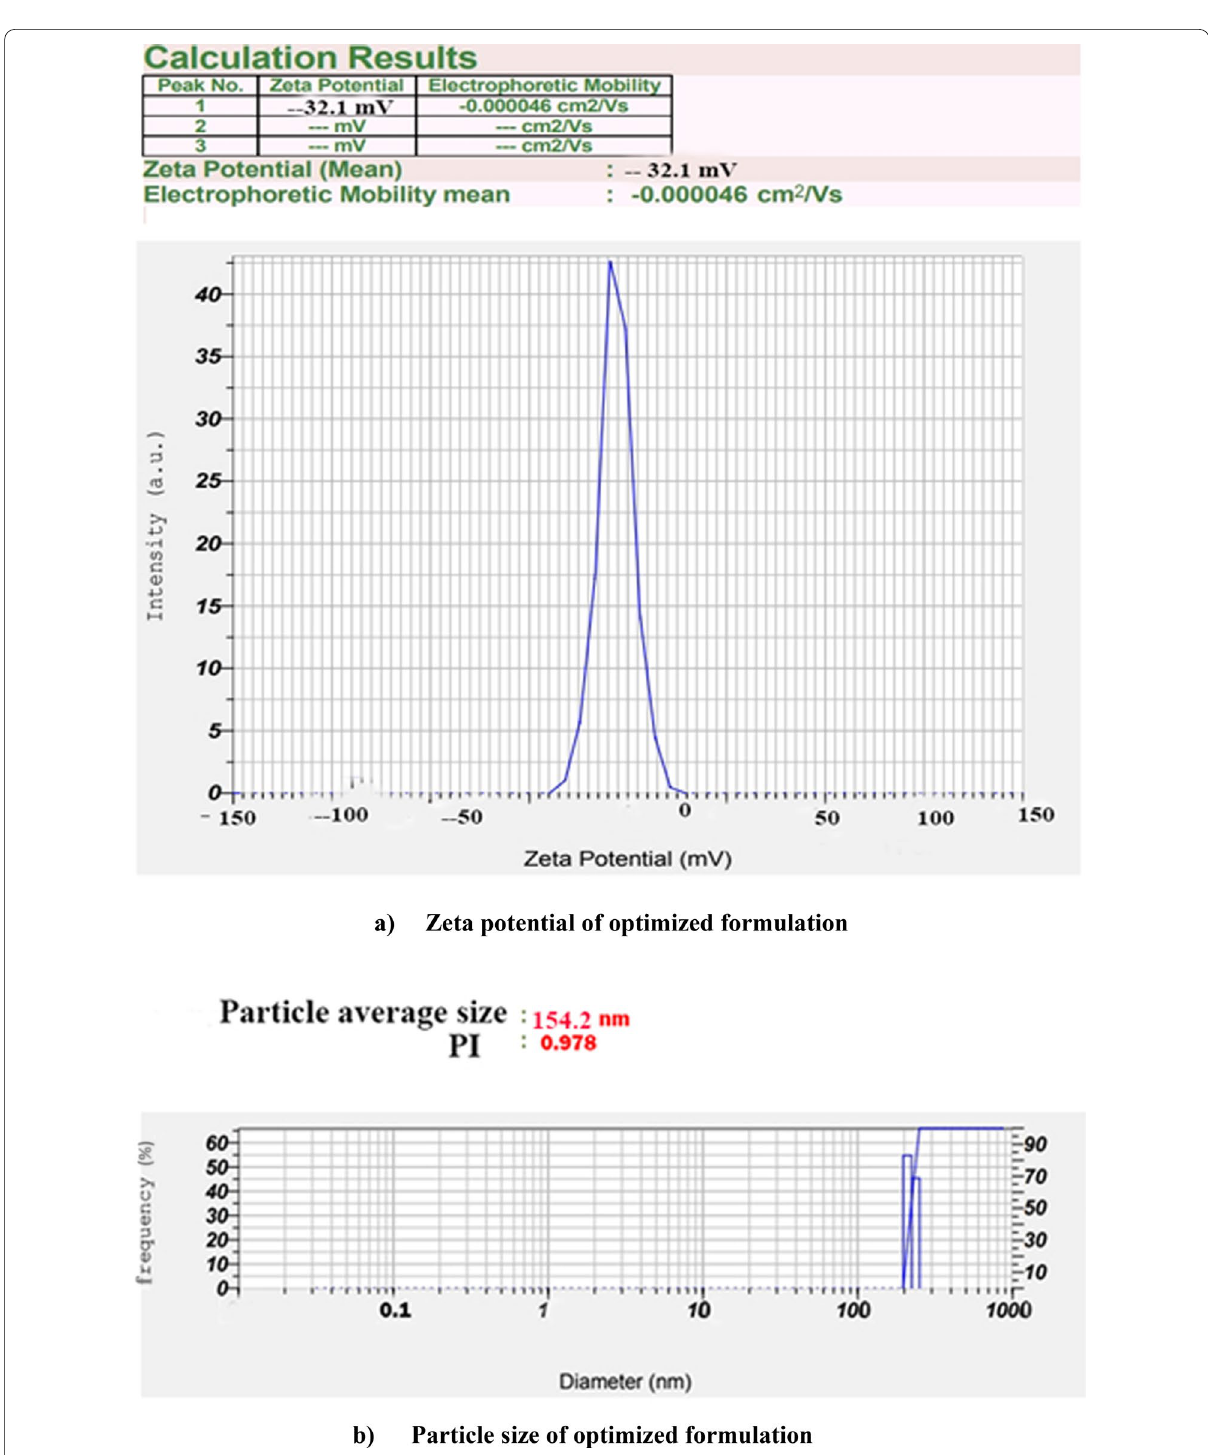
Fig. 9 a Zeta potential and b particle size of optimized